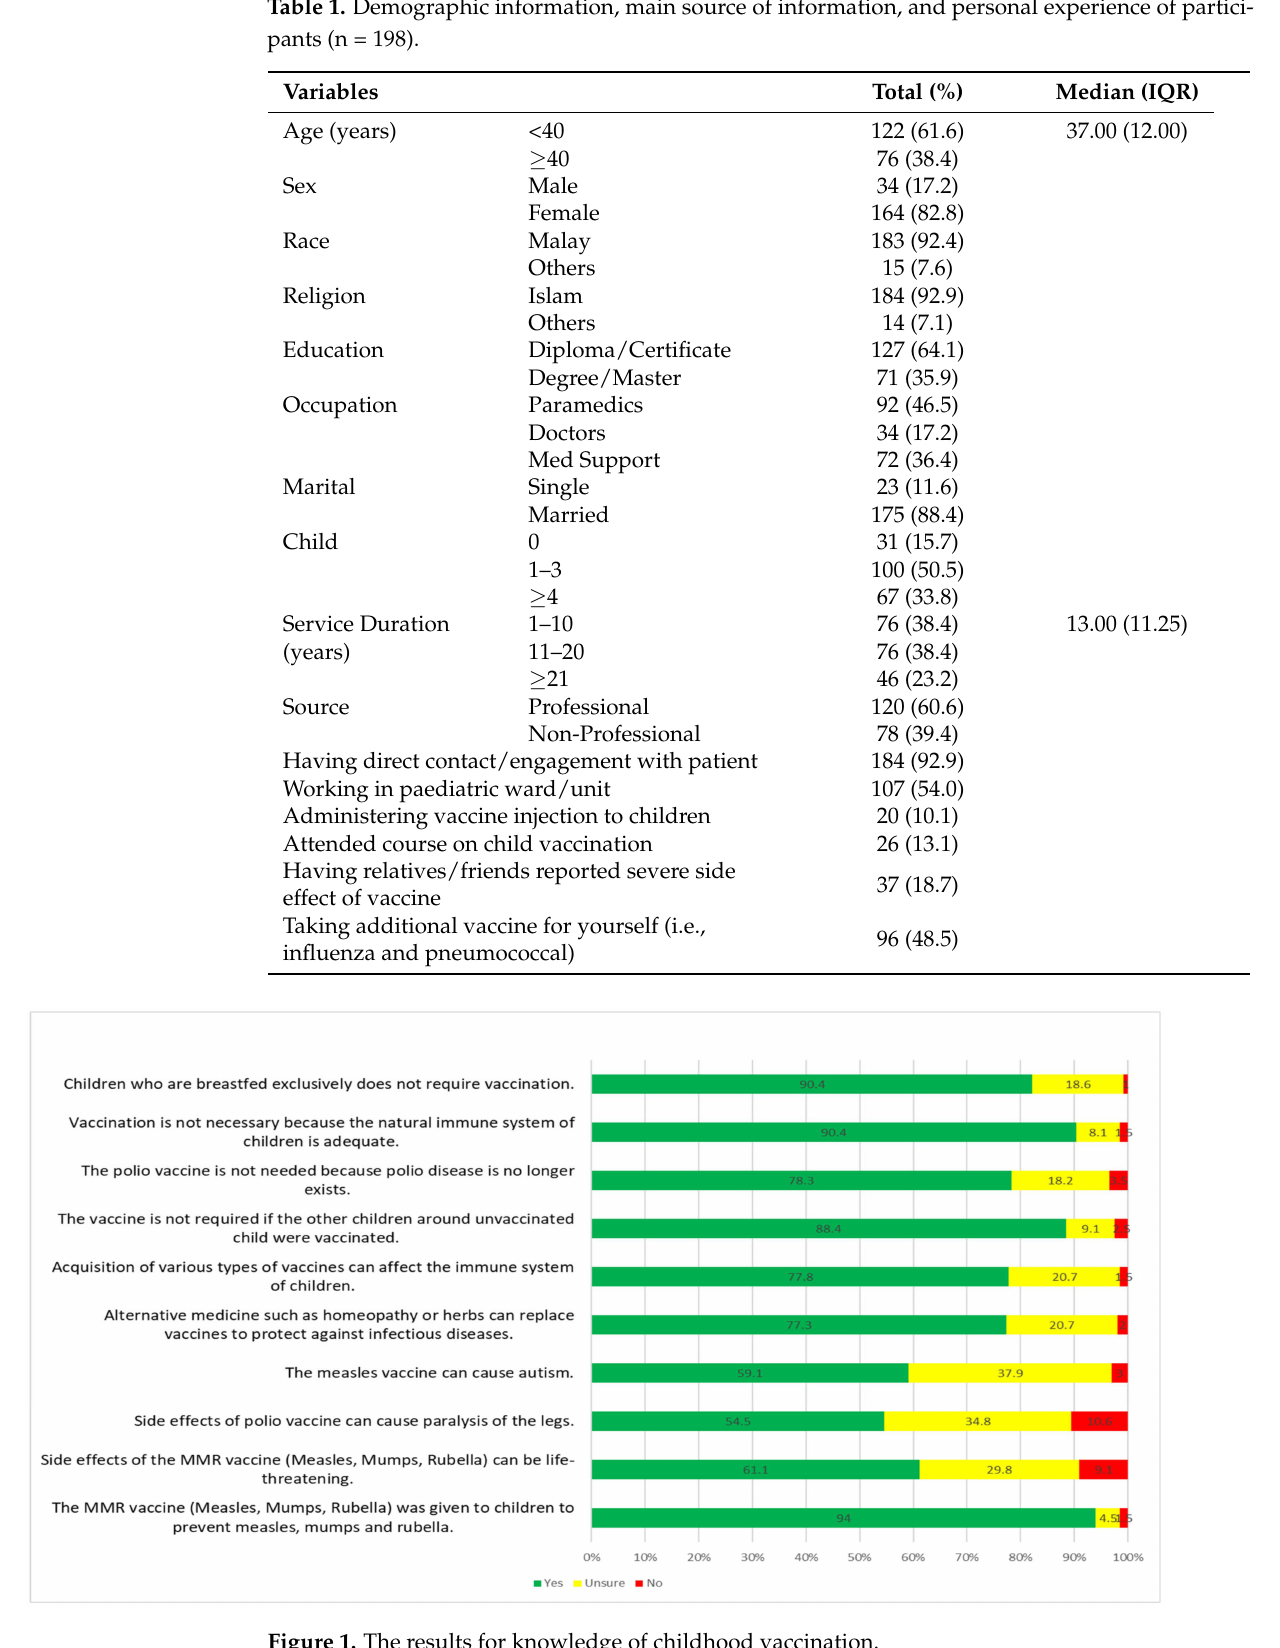
Figure 1. The results for knowledge of childhood